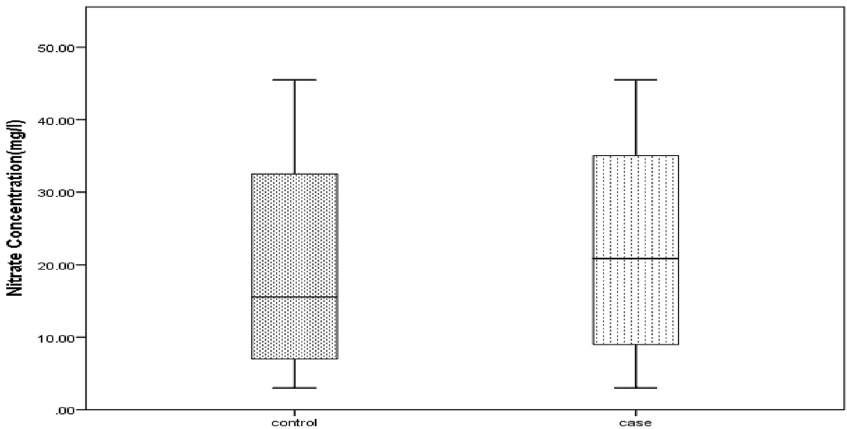
Figure 3. Box plot of serum NO3 level distribution in the case and control groups with thyroid